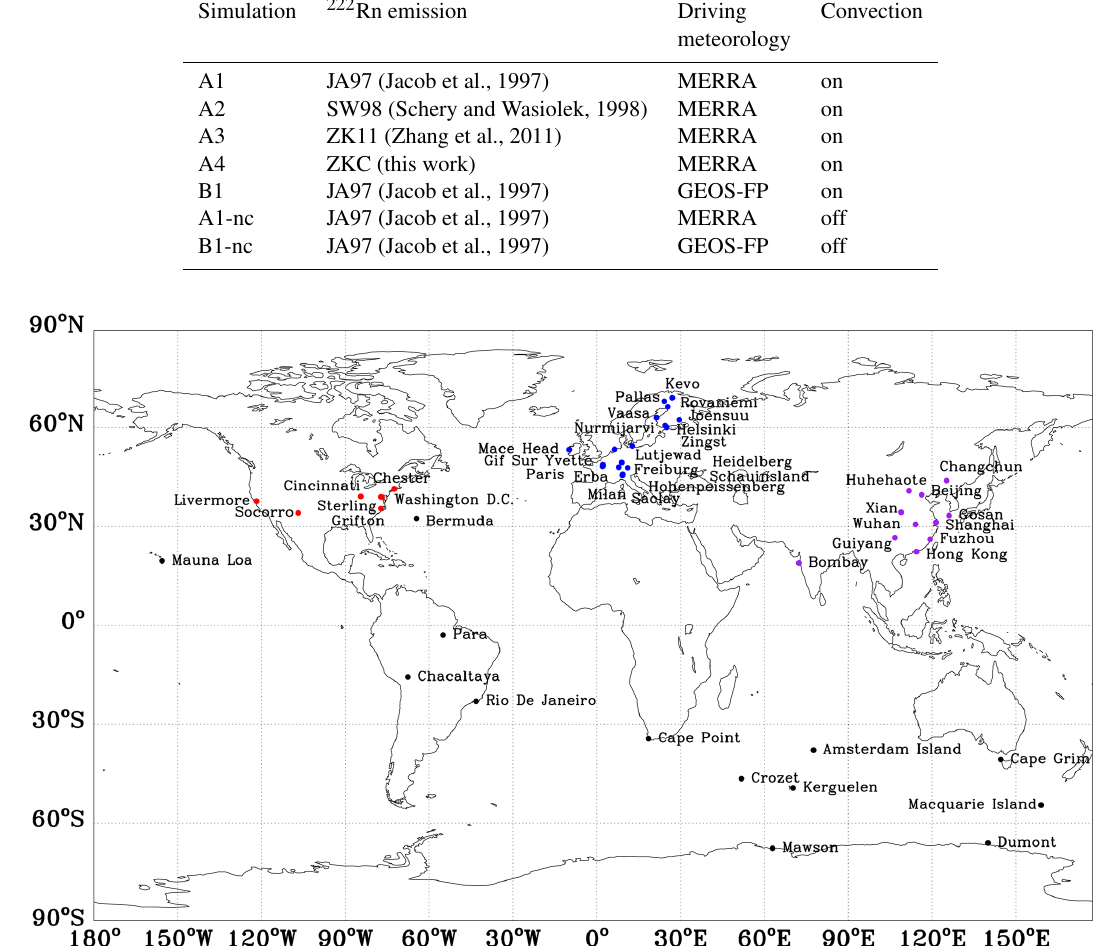
Figure 4. Locations of surface 222 Rn measurement sites. Sites in four distinctive regions are color-coded: Europe (blue), Asia (purple), North America (red), and remote regions (black). Refer to Table 2 of Zhang et al. (2011) for more